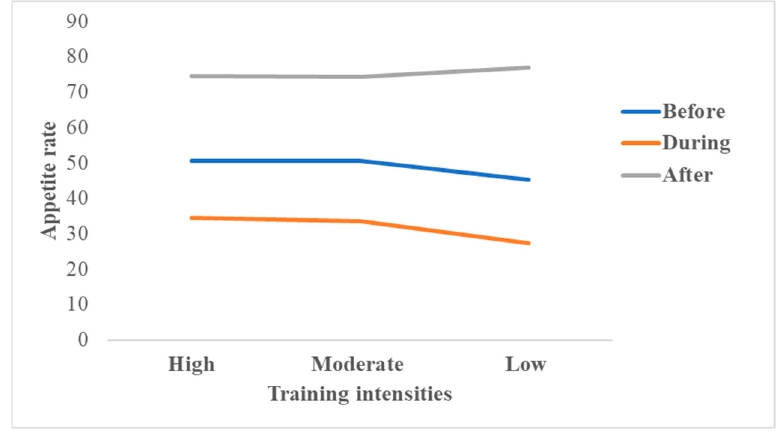
Figure 3. Appetite scores after training depending on the three training intensities.